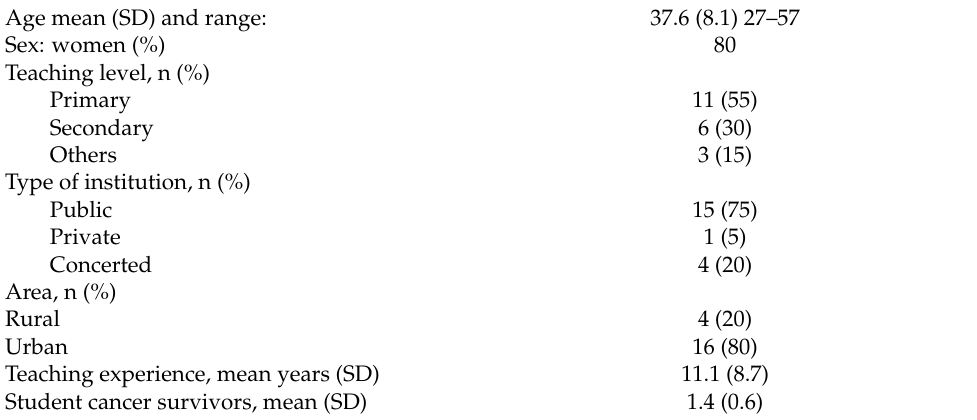
Table 3. Sample characteristics from Round II (n =